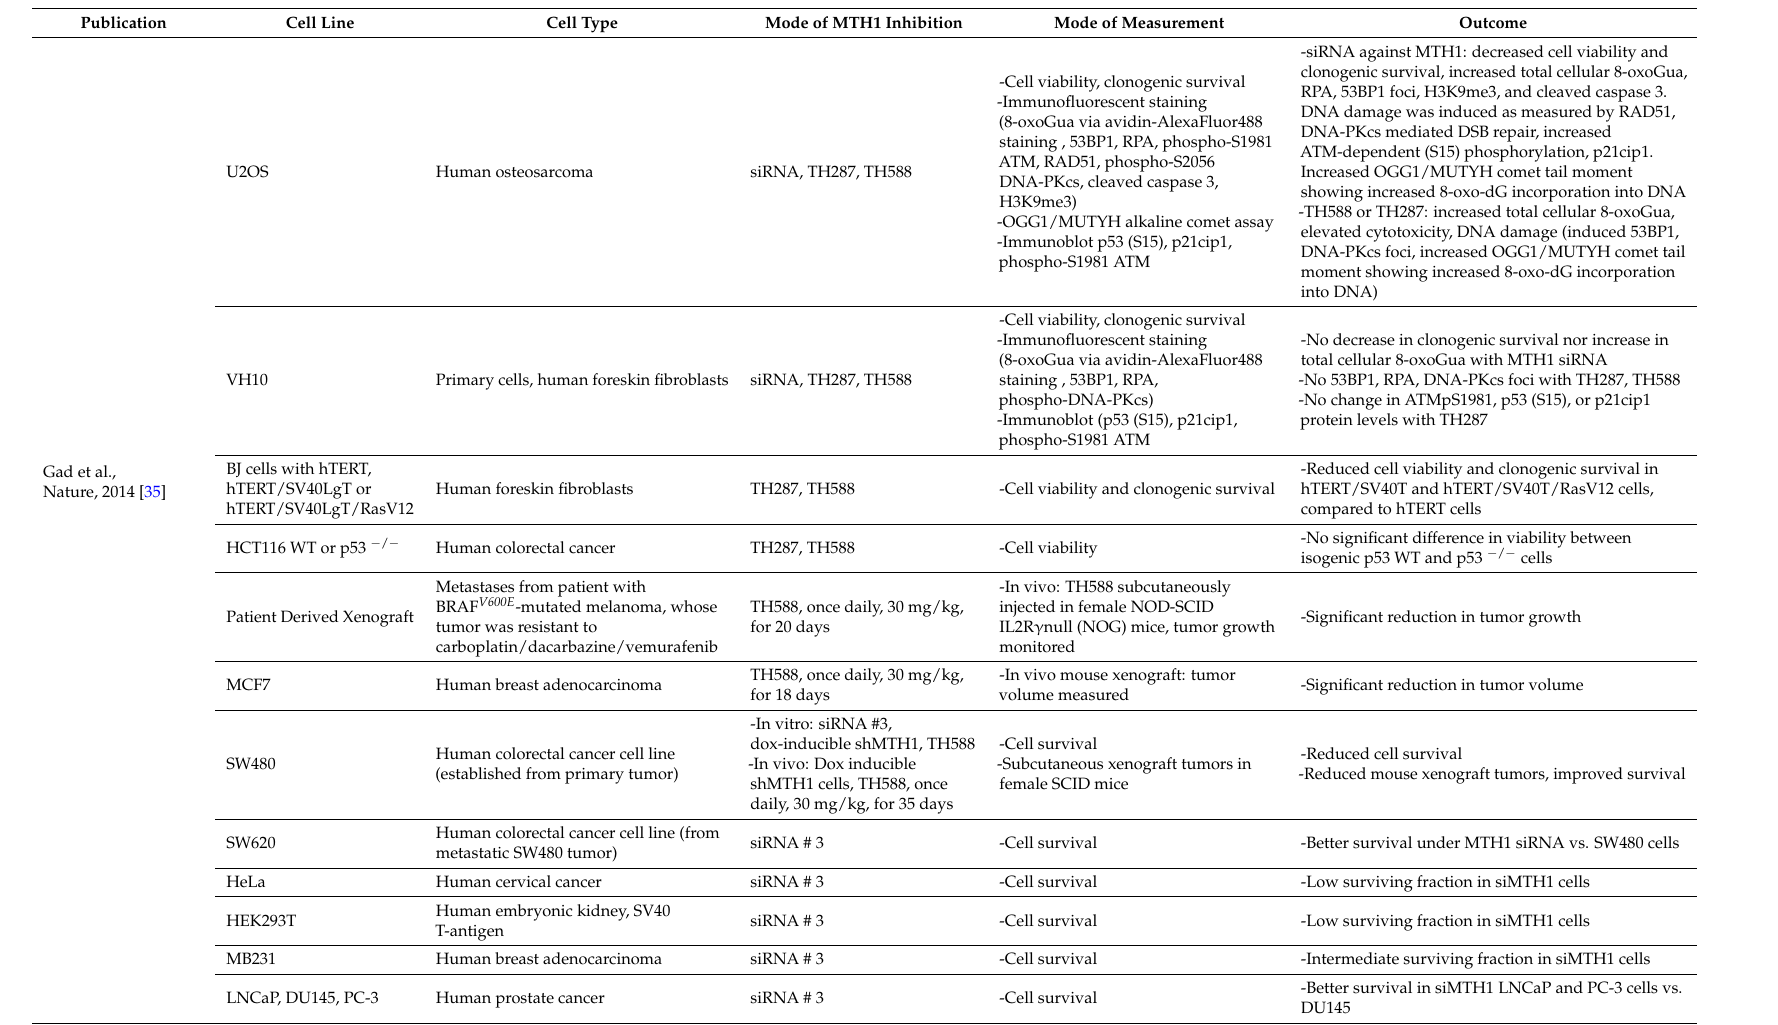
Table 1. Summary of current MTH1 inhibitors and their